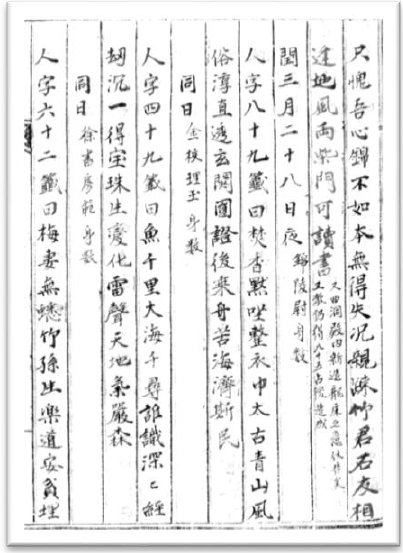
Figure 4. Oracle Poems for the Triad of Enlightenment Party ( Collection of Sacred Spirit-writings [SGJ], 47a).